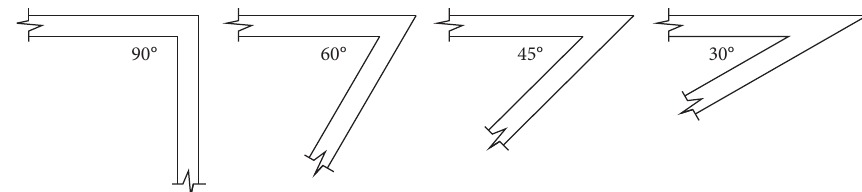
Figure 26: L-shaped connections with different branch